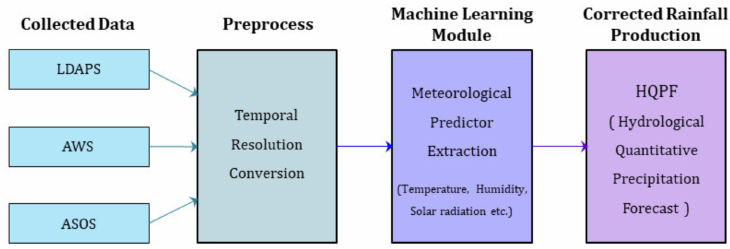
Figure 6. Schematic diagram of machine